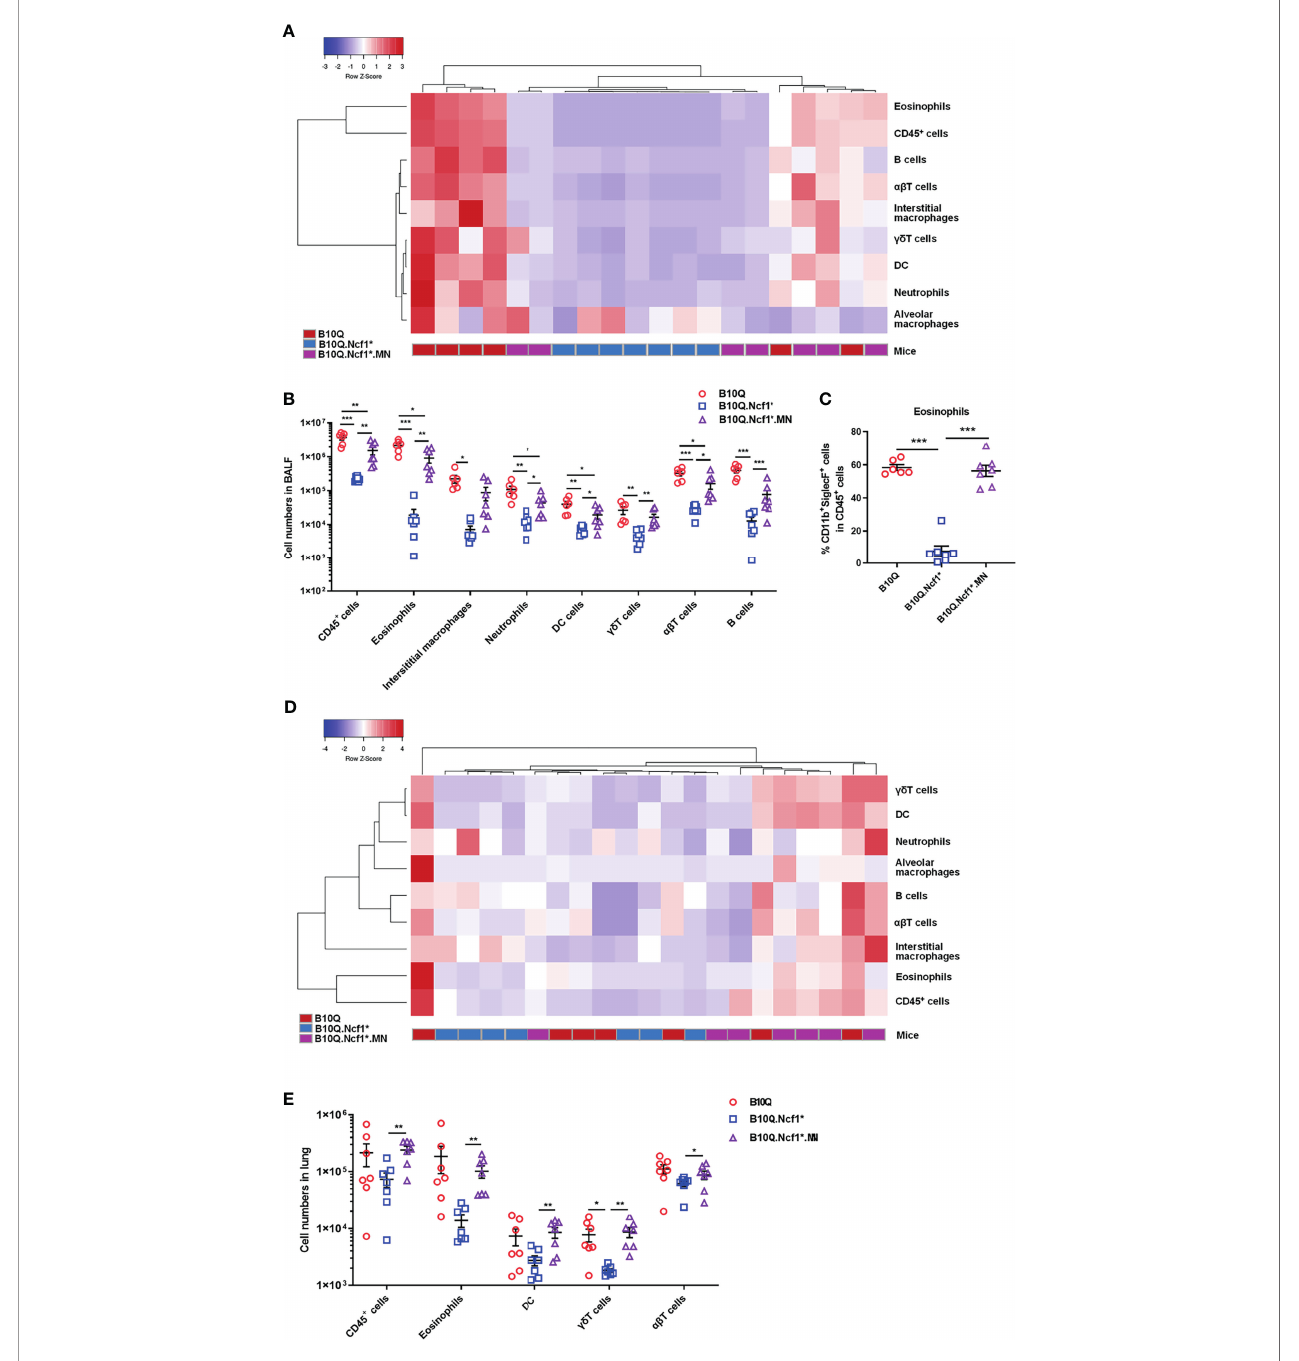
FIGURE 3 | Ncf1 de fi ciency reduces in fl ammatory in fi ltration in lung in fl ammation. (A, B) B10Q, B10Q. Ncf1 * and B10Q. Ncf1 *.MN mice were induced AIPI, the number of cells in BALF were detected by fl ow cytometry (n = 6-7 per group). Heat map with cell pro fi le of each mouse, and the statistical analysis of cells with differences between groups are shown. (C) The proportion of eosinophils (CD11b + SiglecF + cells) in CD45 + cells of BALF is shown in histogram. (D, E) Additionally, immune cells in lung tissues (upper left lobes) from the three strains were also detected by fl ow cytometry (n = 7 per group). Heat map with cell pro fi le of each mouse, and the statistical analysis of cells with difference among groups are shown. All values are expressed as means ± SEM. * P < 0.05, ** P < 0.01 and *** P < 0.001, using one ‐ way ANOVA with post ‐ hoc comparison (Fisher ’ s)